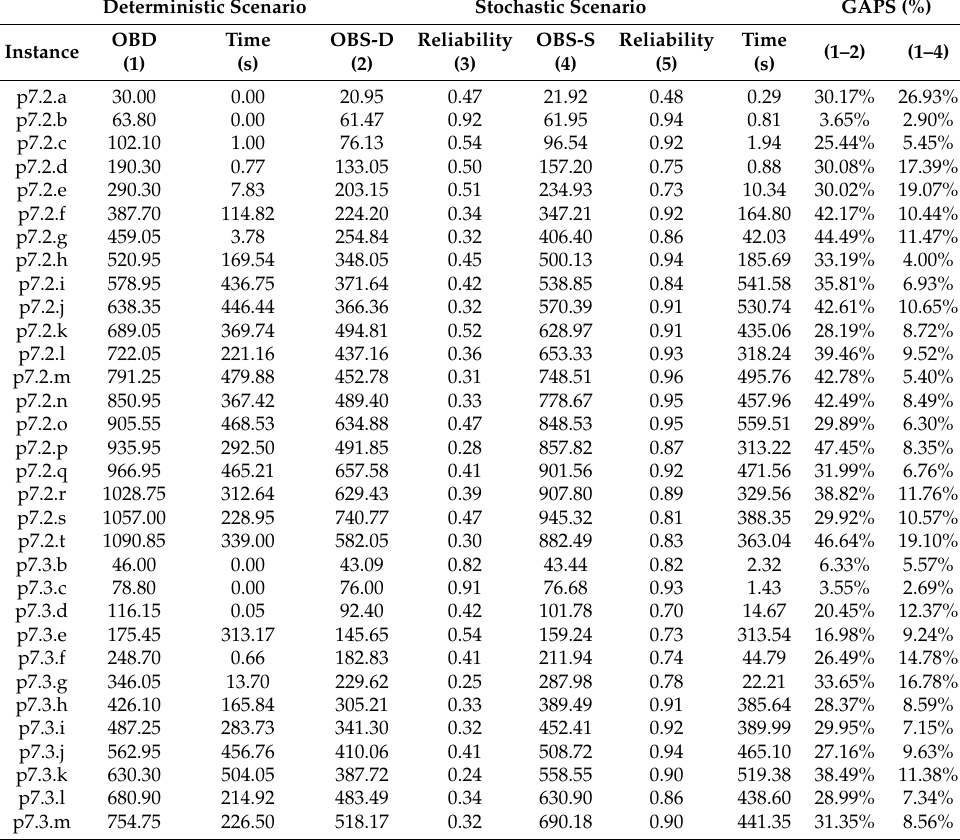
Table 12. Results for p 7 instances in a stochastic scenario with a high variance ( c =